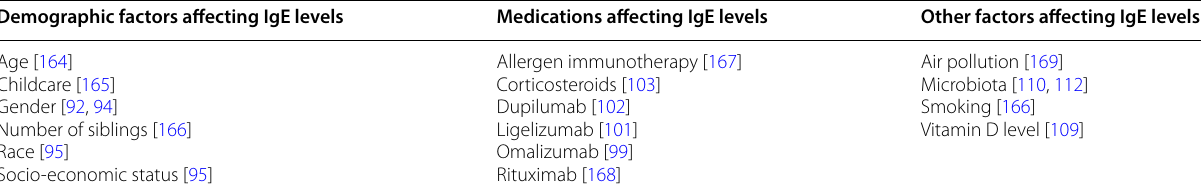
Table 4 Other factors affecting IgE levels Demographic factors affecting IgE levels Medications affecting IgE